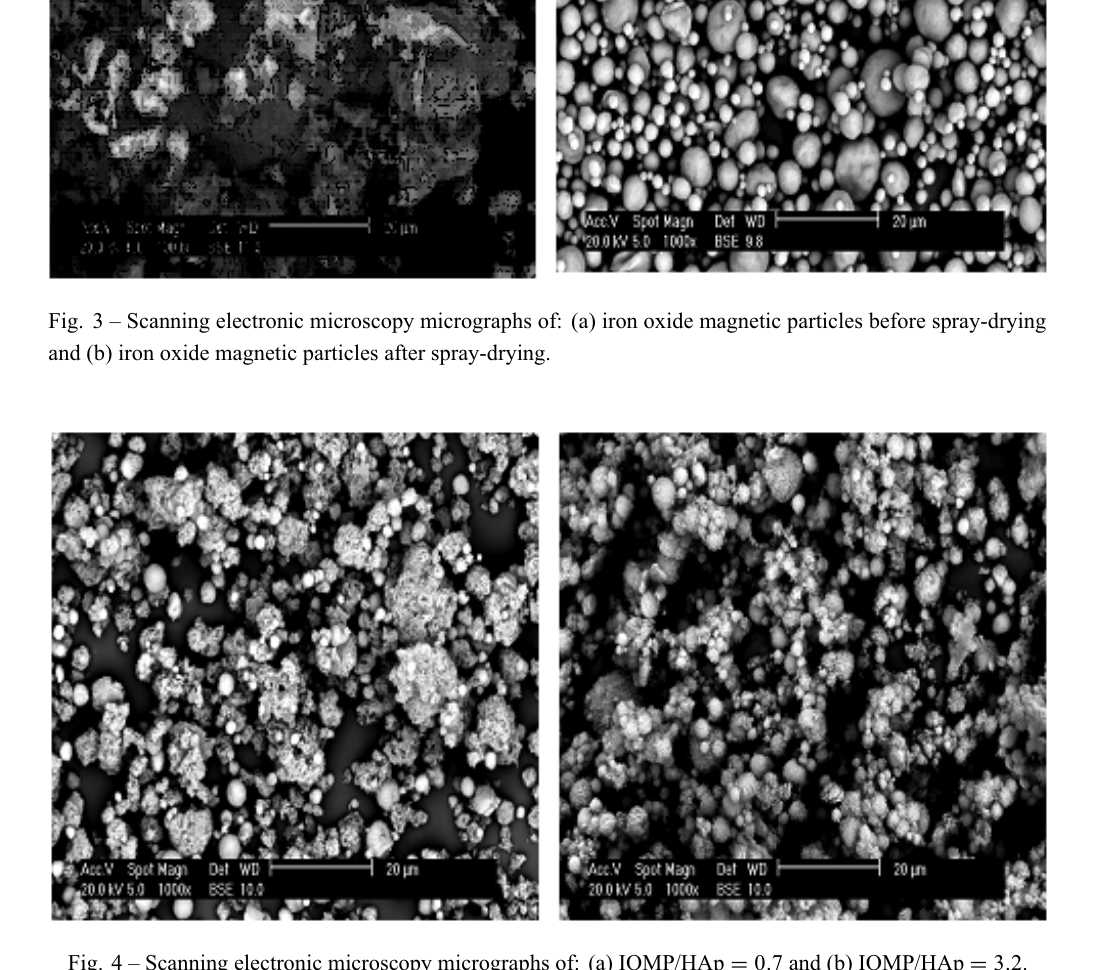
Fig. 4 – Scanning electronic microscopy micrographs of: (a) IOMP/HAp = 0 . 7 and (b) IOMP/HAp = 3 .